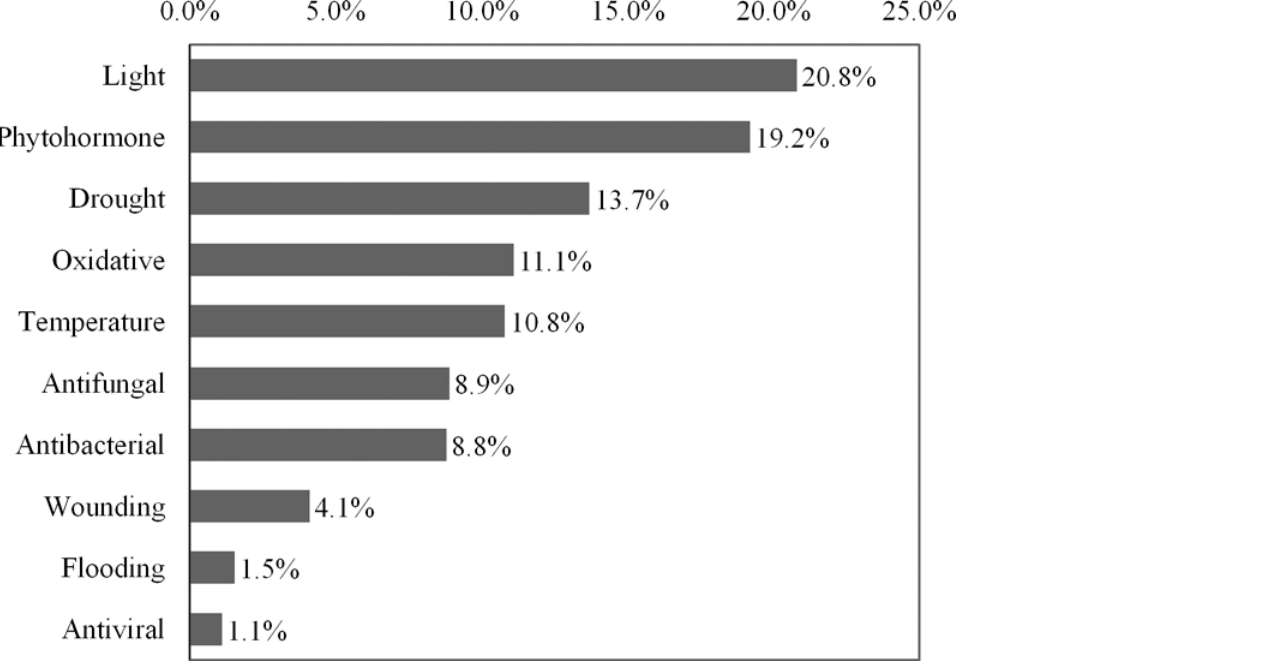
Fig 6. Distribution of 919 stress-related genes out of 3,135 uniESTs.